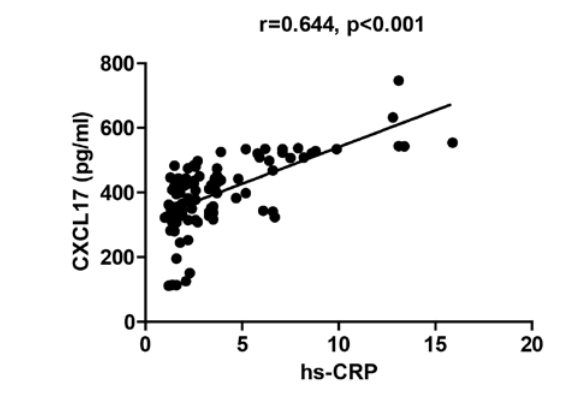
Figure 1: The correlation between CXCL17, hs-CRP. The CXCL17 and hs-CRP level in serum of patients with UA. UA: unstable angina.